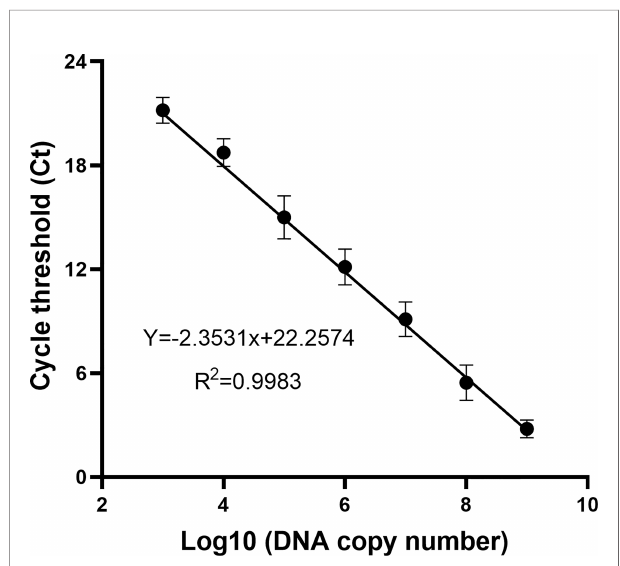
FIGURE 2 | The standard curve of the recombinant plasmid was obtained by a qPCR assay. Of the recombinant plasmid, 2 × 10 9 – 10 3 copies/ml were used as the template for the reaction. A standard curve of the correlation between DNA copy number and qPCR cycle threshold (Ct) value was constructed using GraphPad Prism 8.0. R 2 represents the degree of fi t of the regression